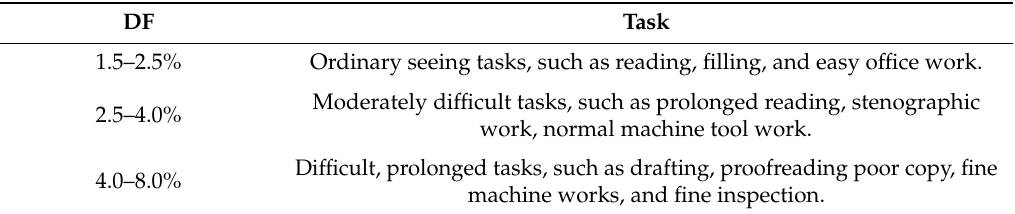
Table 3. Recommended daylight factor according to Stein 1992